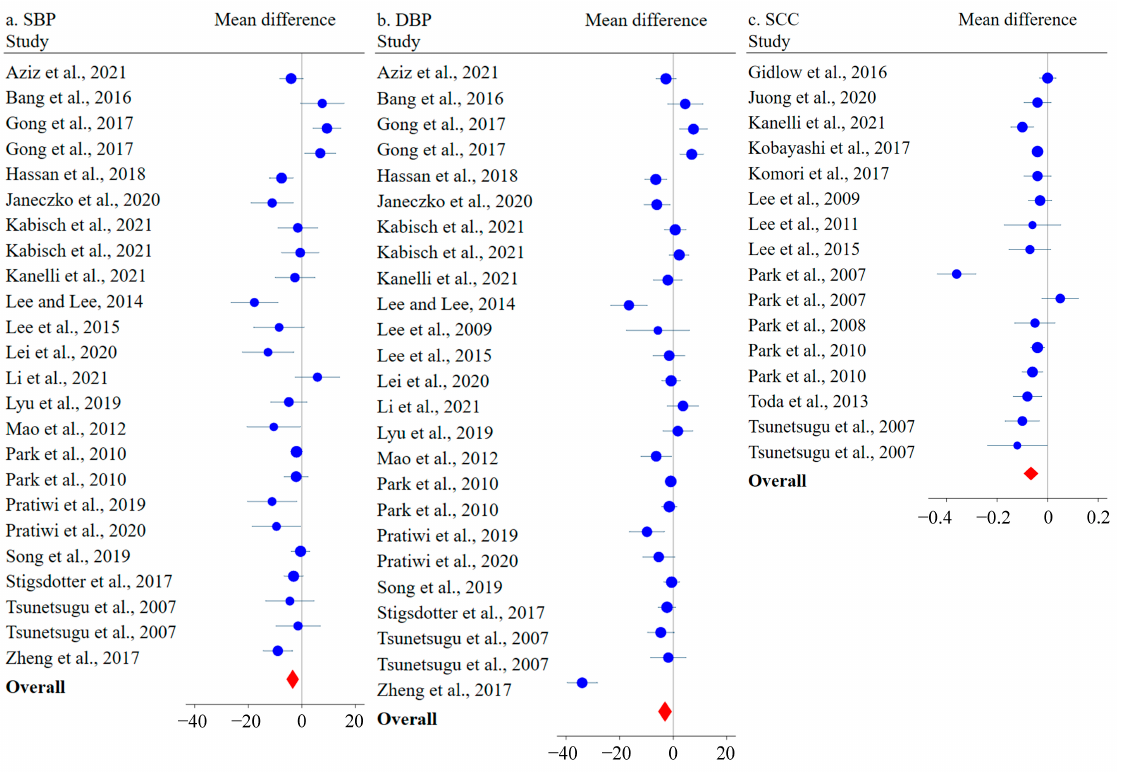
Figure 2. Forest plots referred to the changes in SBP ( a ), DBP ( b ), and SCC ( c ) between forest therapy and urban control, based on meta-analyses [45–73]. The blue dots indicate the effect values for individual studies and the red rhombuses indicate the total effect values.